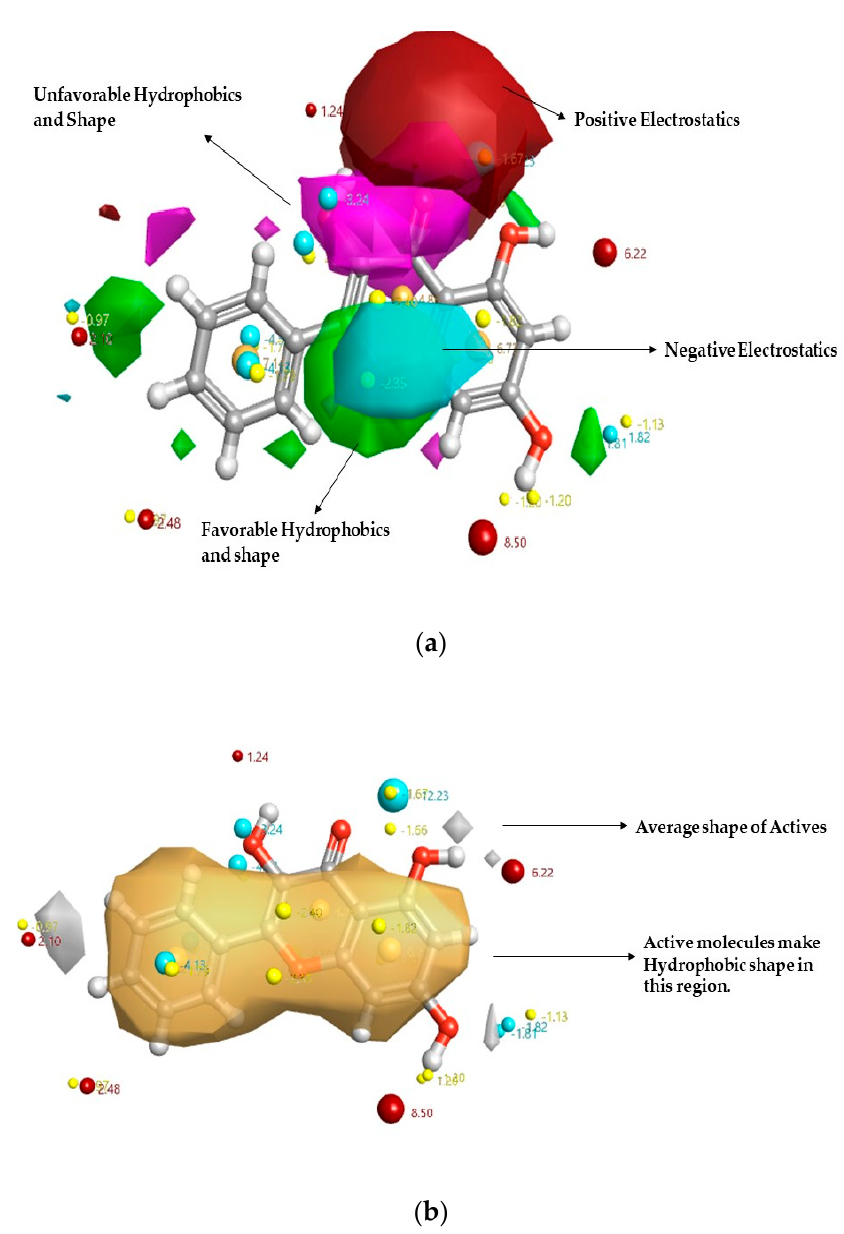
Figure 2. Qualitative structure–activity relationship (SAR) model of the DPP-4 inhibitor model map is superposed to galangin. The molecular insight of SAR mechanism models, revealing DPP-4 inhibitors of natural compounds, as detected through an average of actives and activity cliff summary study: ( a ) Positive field region is shown in red controls the DPP-4 inhibitory activity; green color shows favorable hydrophobic feature and pink color shows unfavorable hydrophobic shape; While the negative region in cyan: ( b ) The white region shows the inhibitory activity shape feature, and yellow color shows the hydrophobic shape of inhibitory activity.